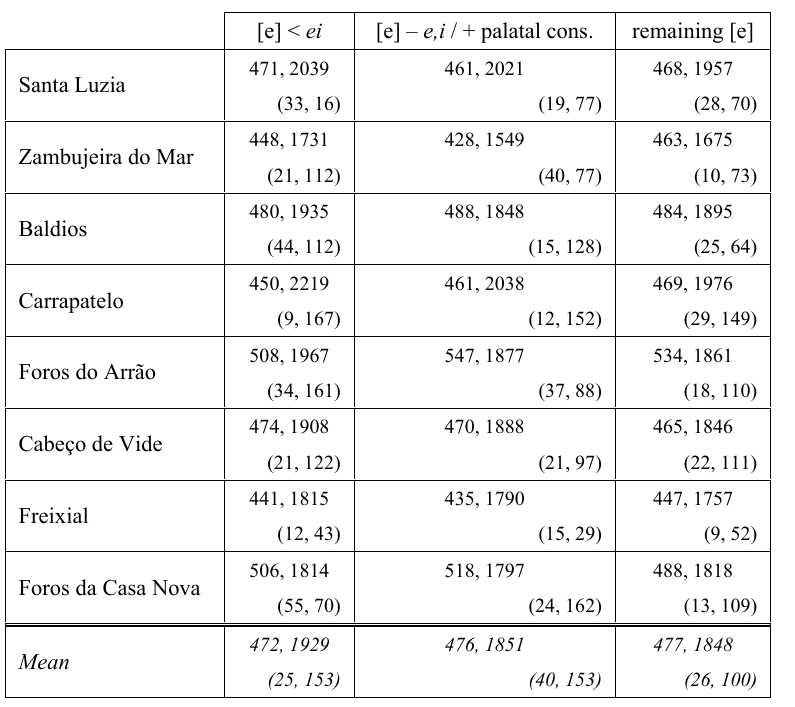
Table IV. Mean values: F1, F2 (standard deviations in